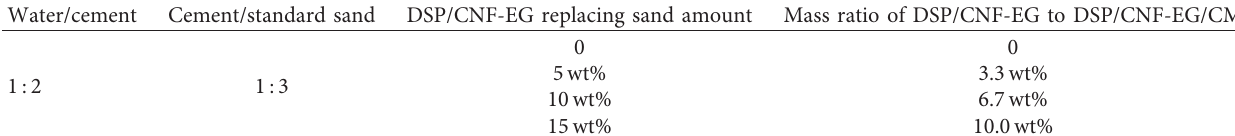
Table 2: Mix proportion of cement mortar.